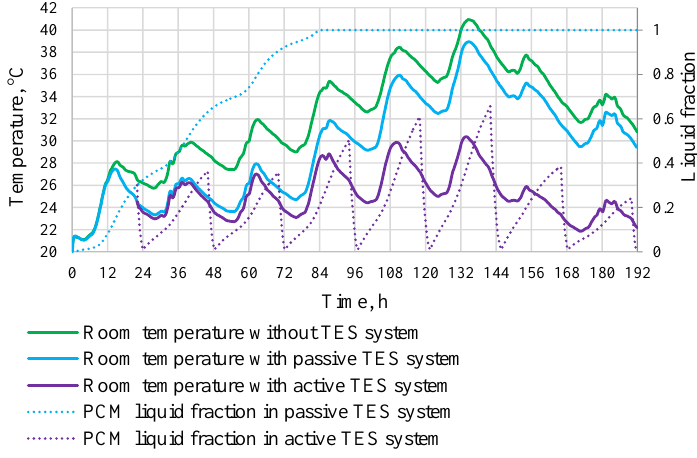
Fig. 6. Dependences of temperature and liquid fraction on